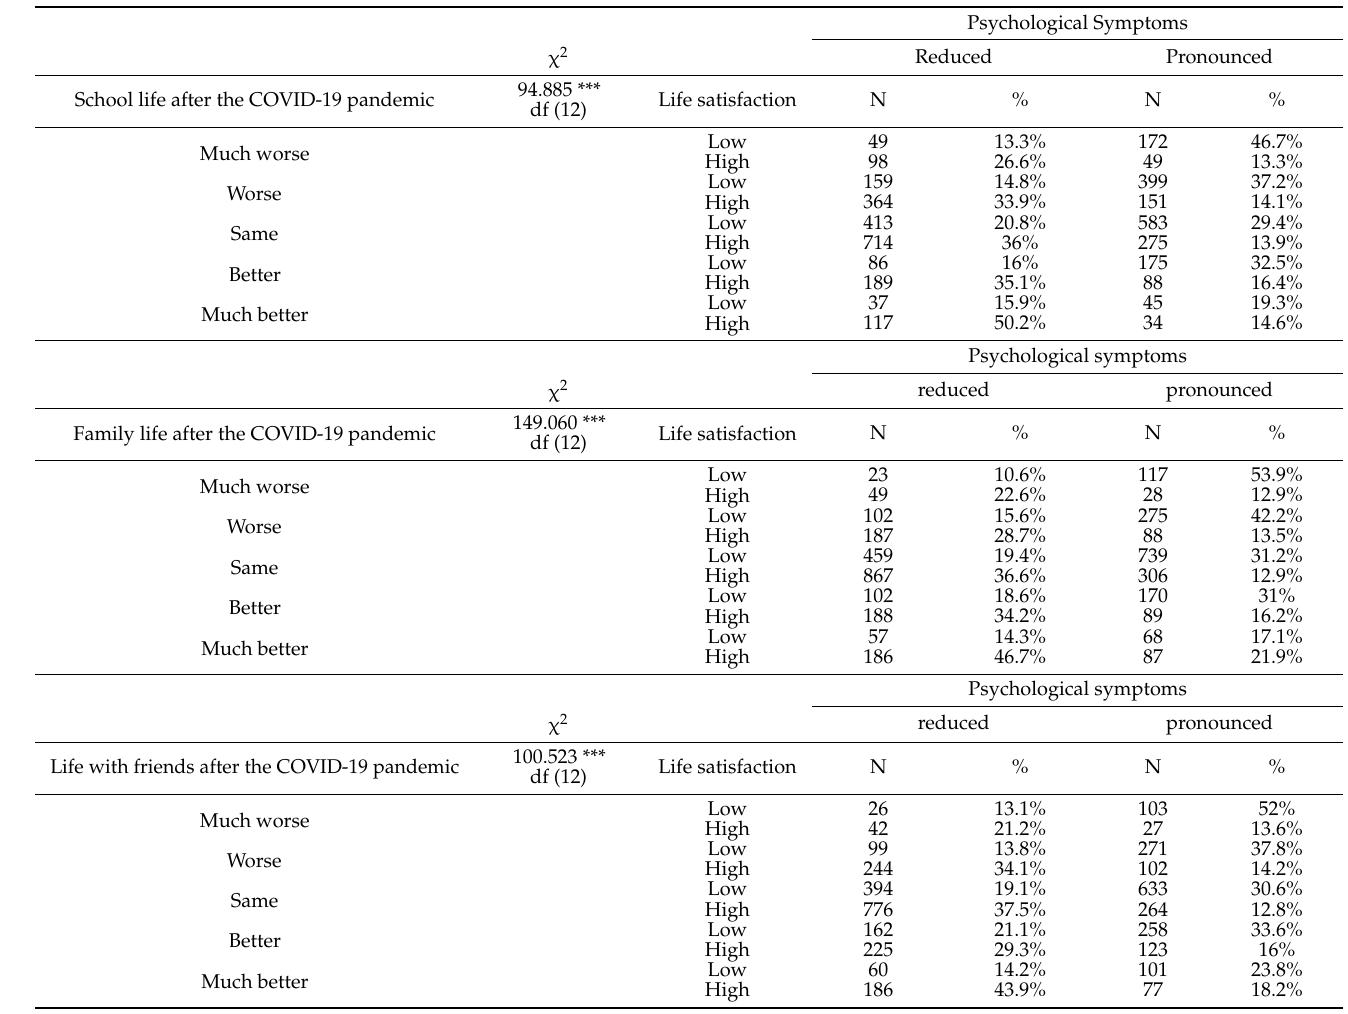
Table 4. Associations of psychological symptoms and life satisfaction with life changes at school, family life, life with friends, with oneself, and in general after the COVID-19 pandemic. Psychological Symptoms χ